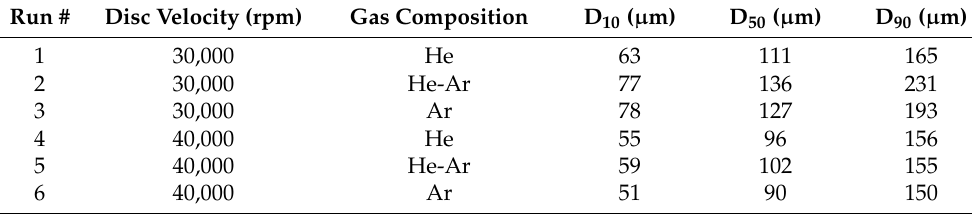
Table 1. Description of atomization runs and particle size distribution